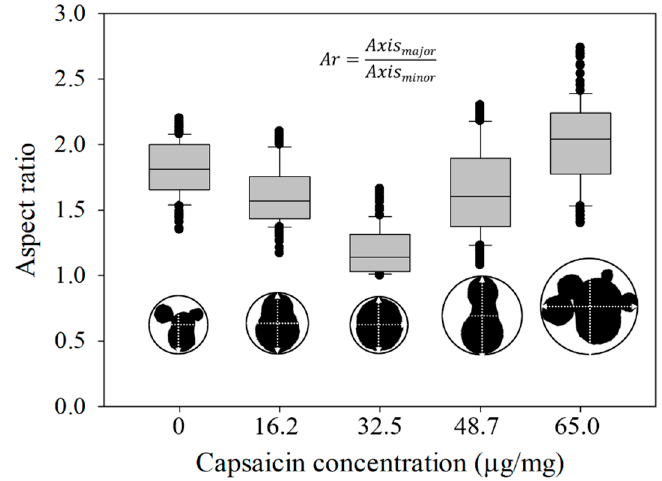
Figure 6. Aspect ratio of the isolated nanoparticles showed a gradual transition from irregular dimension (X-Y axis) to circular shape and irregular aspect at high concentration of capsaicin. The equation of aspect ratio ( Ar ) is also displayed. Conditions: digital measurement of n = 180 nanoparticle images at 1376 × 1032 pixels and 8 bits of compression; resolution set at 2.1 pixels/nm. Values are the means of three experimental replicates ± standard deviations.